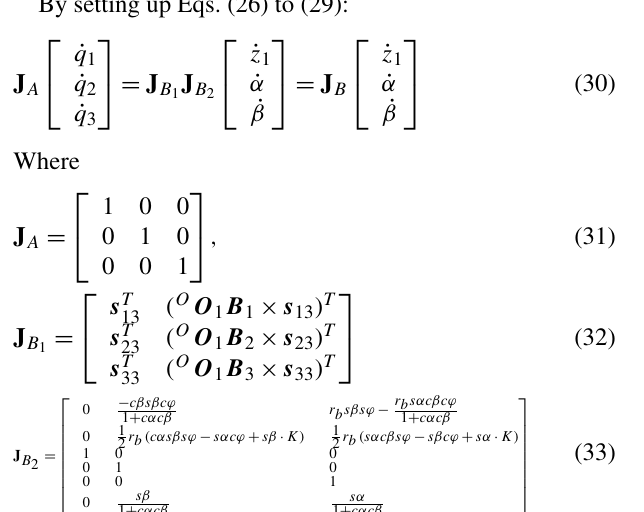
Figure 5. Singularity distribution of RPS mechanism in range of workspace − 20 ◦ <α < 20 ◦ , − 20 ◦ <β < 20 ◦